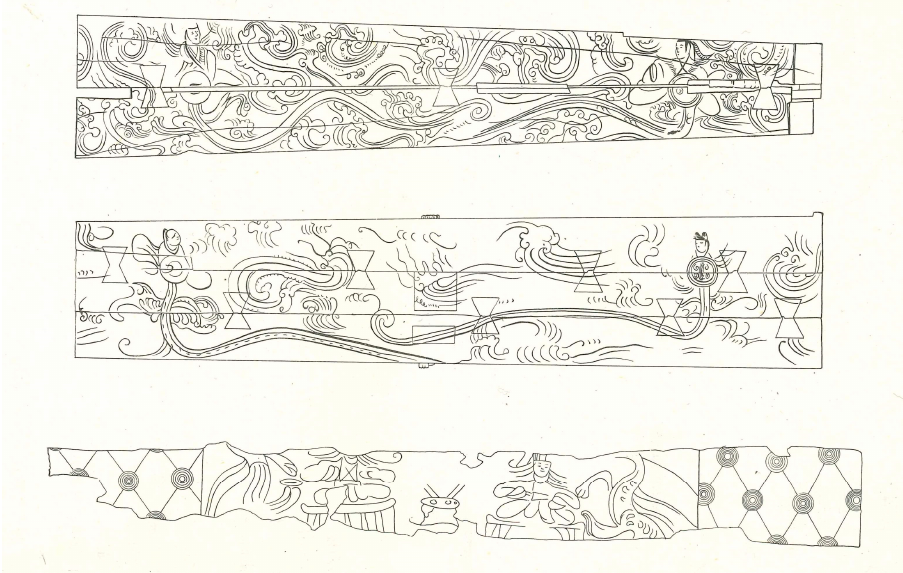
Figure 11. Drawing of coffin lids with Fuxi and Nüwa from Xincheng M1 and the Queen Mother of the West and King Father of the East, from Xincheng M6 incised wood with lacquer, Wei‑Jin period (220–317). (Gansusheng Bowuguan et al. 1985, Figure 19). ©Wenwu Press. This figure published with permission of Wenwu Press and cannot be used or copied without their